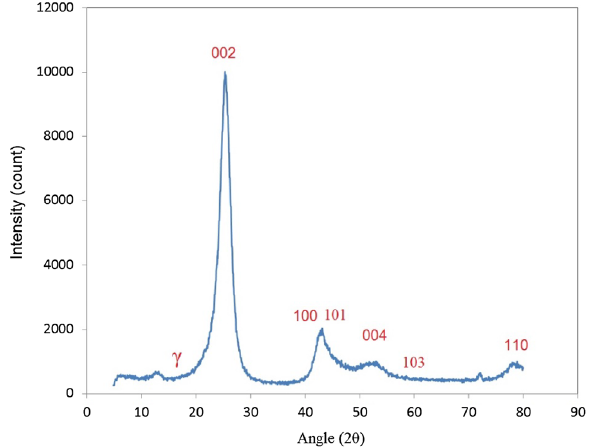
Fig. 2 Graphical implementation of REBF filled by ceramic balls and catalytic coke Fig. 3 XRD pattern of un-graphitized coke